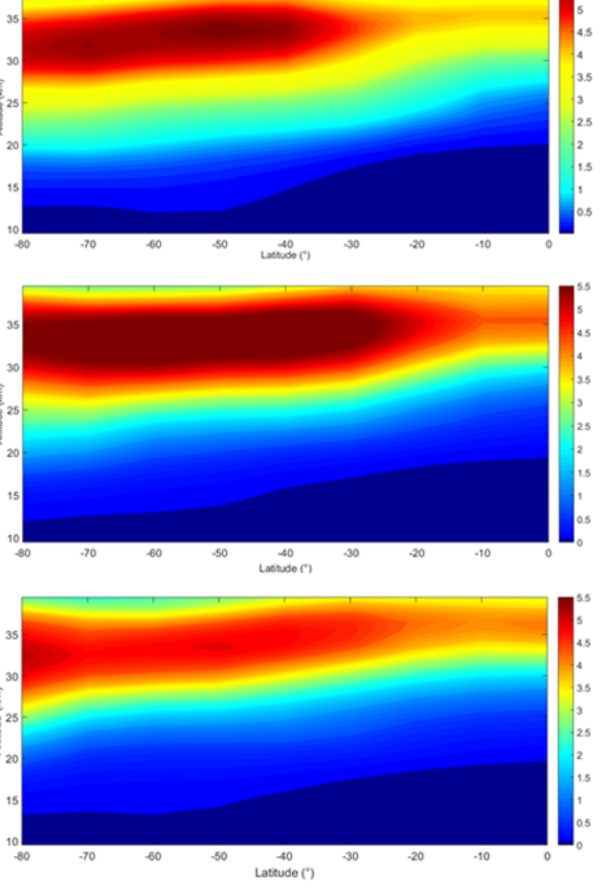
Figure 10. Climatological map of zonal mean NO 2 volume mixing ratio (ppb) with 10 ◦ latitudinal binning and 1km vertical binning centred at altitudes between 9.5 and 39.5km for November (2001– 2014, top), January (2002–2014, middle), and March (2002–2014,